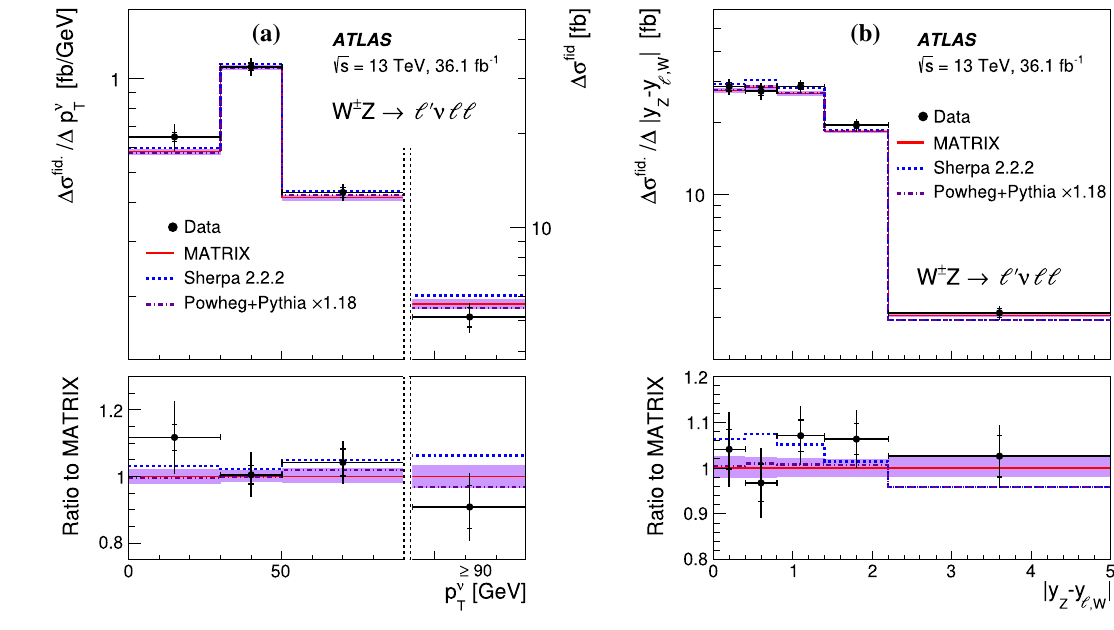
Fig. 5 The measured W ± Z differential cross section in the fiducial predictions. The predictions from the Powheg+Pythia and Sherpa phase space as a function of a p ν and b | y Z − y (cid:4), W | . The inner and MC generators are also indicated by dotted-dashed and dashed lines, T outer error bars on the data points represent the statistical and total respectively. In a , the right vertical axis refers to the last cross-section uncertainties, respectively. The measurements are compared with the point, separated from the others by vertical dashed lines, as this last bin NNLO prediction from MATRIX (red line, see text for details). The is integrated up to the maximum value reached in the phase space and violet band shows how the QCD scale uncertainties affect the NNLO the cross section is not divided by the bin